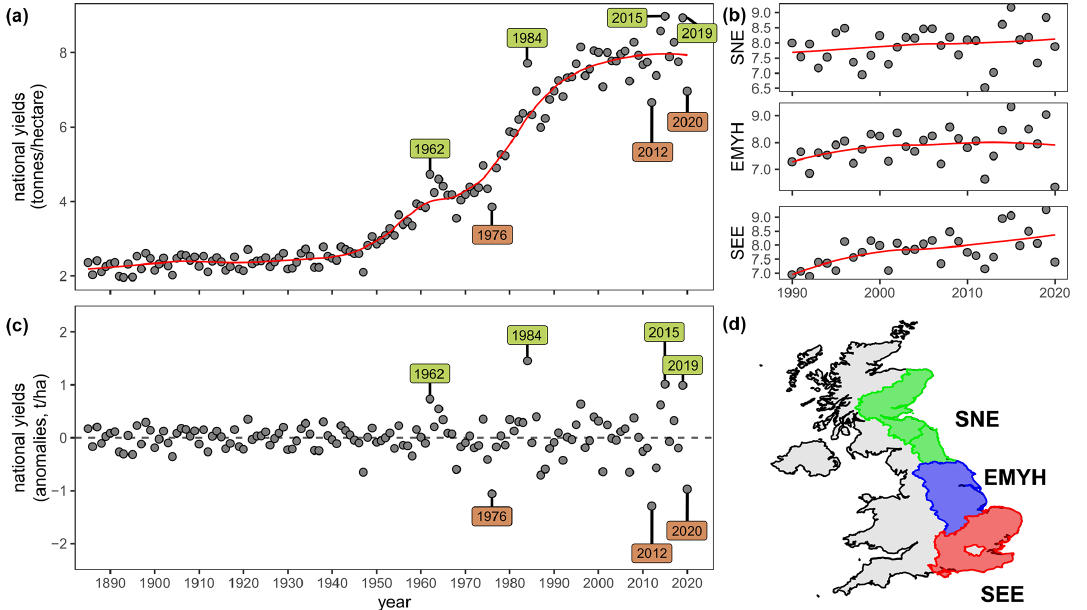
Figure 1. UK national and regional wheat yields. (a) National wheat yields are shown as grey circles and locally weighted scatterplot smoothing (loess) curve as a red line. Green labels indicate examples of years with anomalously high yields; brown labels indicate examples of years with anomalously low yields. Panel (b) same as (a) for three main wheat-growing regions (data only available for 1990–2020 at the regional scale). (c) Anomalies of wheat yields computed by subtracting the Loess moving mean from the annual values. (d) Map of the three wheat-growing regions. Green indicates north-eastern Scotland, eastern Scotland, and the north-east English region (SNE); blue indicates the East Midlands, Yorkshire and the Humber region (EMYH); red indicates the south-east and eastern region